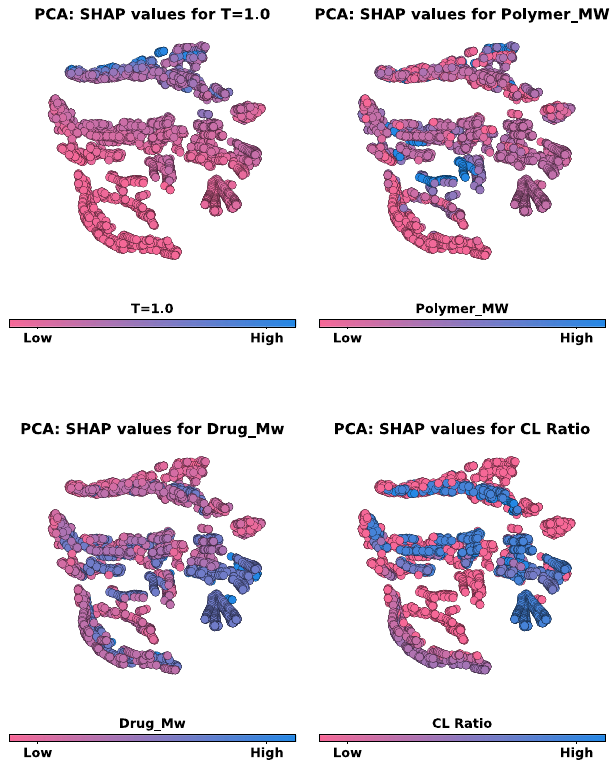
Fig.6|DimensionalityreductioncombinedwithShapleyadditiveexplanations (SHAP) analysis. Two-dimensional visualization of the SHAP values calculated for the input features of the LGBM model. The SHAP values for the 15 input features were condensed into two principal components using principal component ana- lysis (PCA) and then grouped together using a simple unsupervised clustering algorithm (T-distributed Stochastic Neighbor Embedding). This low-dimensional/ clustered plot was then utilized to visualize and compare the location of data instances corresponding to different input features, including T= 1.0; CL_Ratio ; Polymer_MW ;and Drug_Mw .Ineach case,theattached colorbar depictsthe relative value of that feature in the dataset ranked from high (blue) to low (pink). Source data are provided as a Source Data fi le.